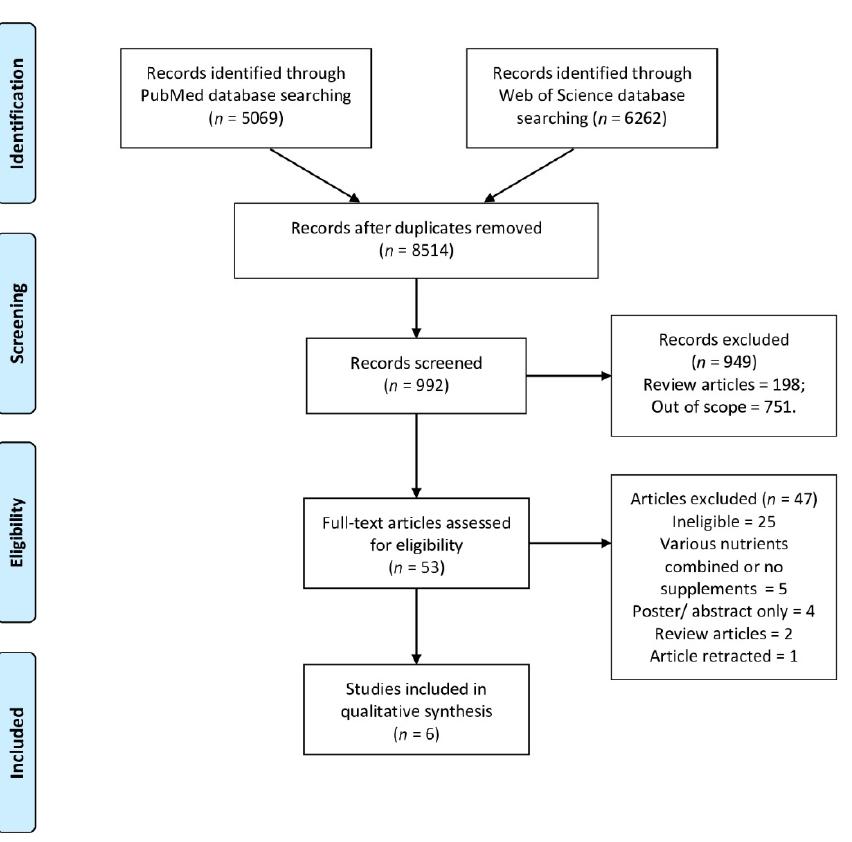
Figure 1. The identification, screening, eligibility, and inclusion within the systematic review.